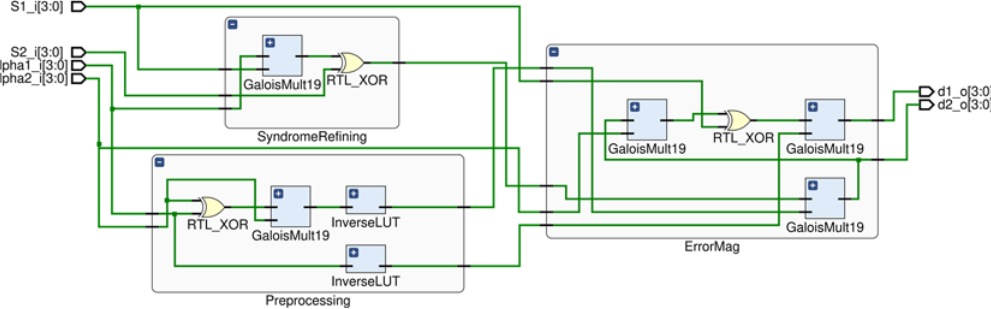
Figure 7. RTL result of the Lu method for the RS(15,11) configuration.